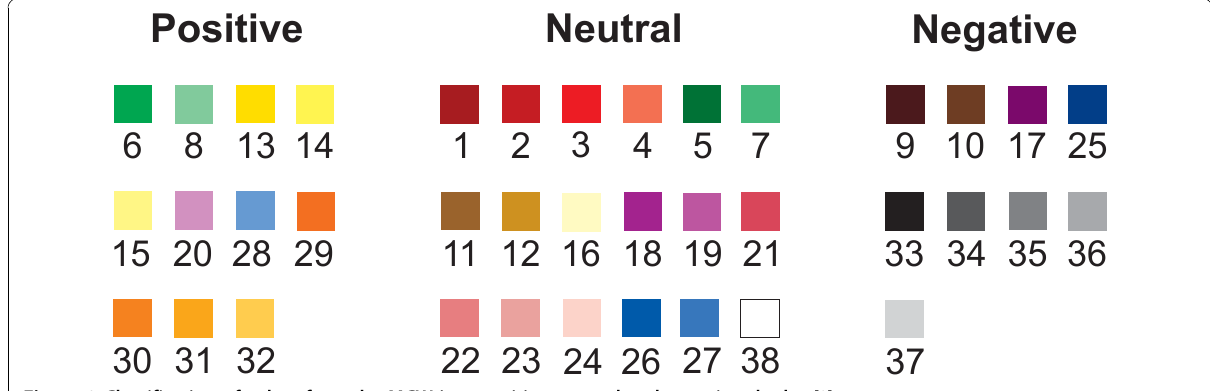
Figure 2 Classification of colors from the MCW into positive, neutral and negative shades [2].